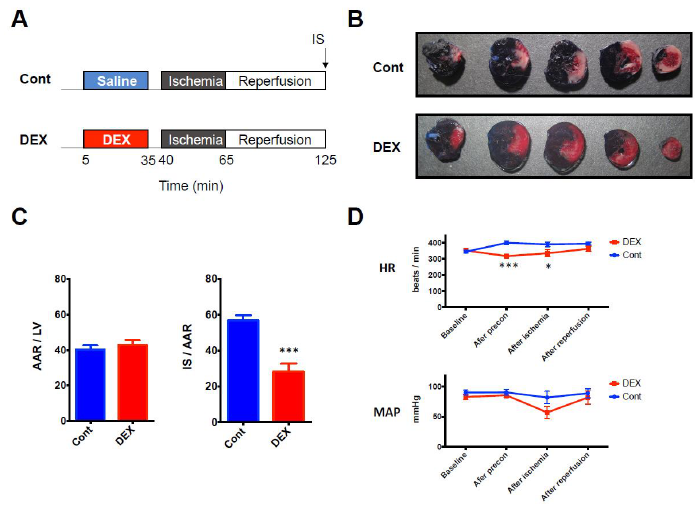
Figure 1. ( A ) I/R experimental protocol. ( B ) Representative LV cross sections. ( C ) Corresponding analysis of AAR expressed as a percentage of LV and IS expressed as a percentage of